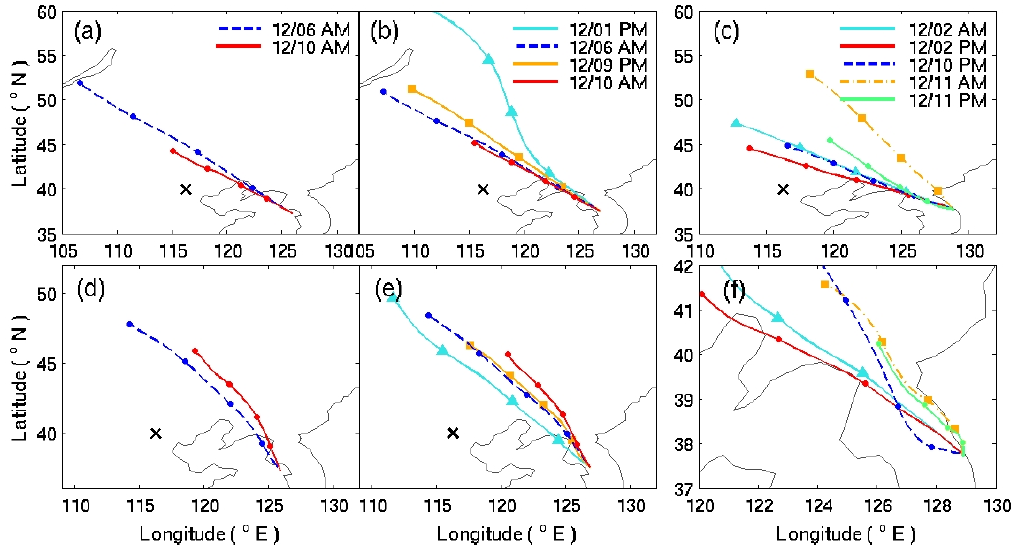
Figure 2. A 24 h back trajectory of airmass arriving at 2000 m ( a – c ) and 500 m ( d – e ) over the Yellow Sea ( a , d ), Seoul ( b , e ) and Gangneung ( c , f ). The heights of 500 m and 2000 m represent the heights within and above the PBL, respectively. Each symbol indicates 6 h marks. X denotes Beijing.